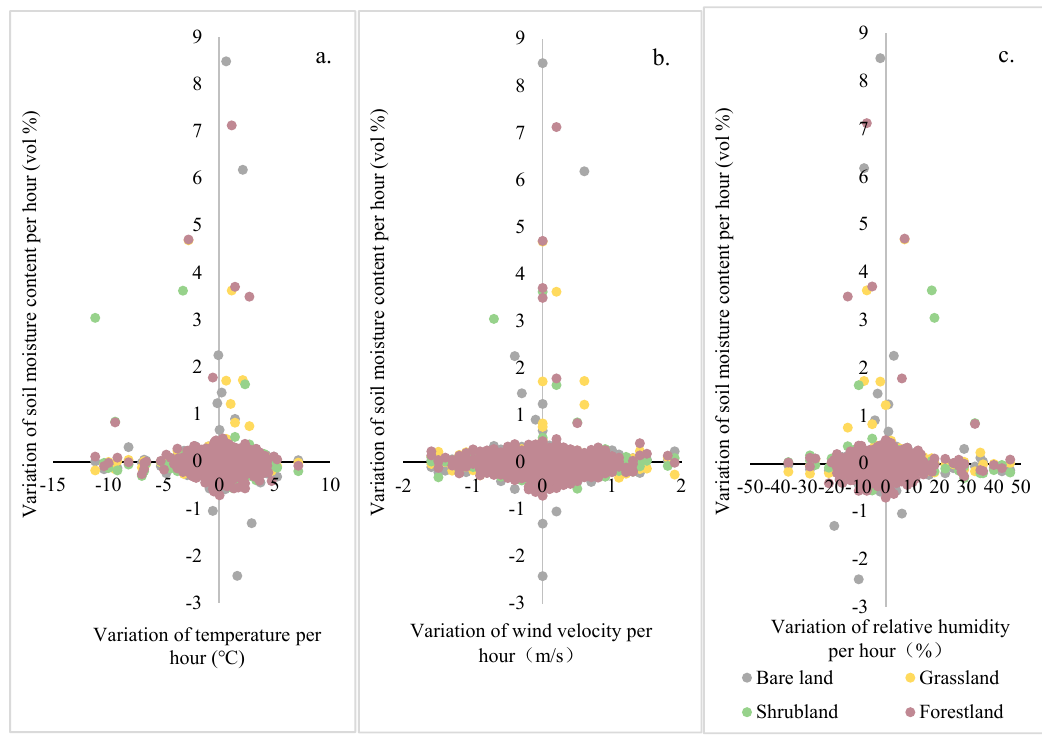
Figure 9. Volumetric soil moisture content variation per hour, with variation of temperature ( a ), wind velocity ( b ), and relative humidity ( c ) per hour during a period without rainfall. Table 12. Results of the Spearman correlation coefficient and significance level between volumetric soil moisture content variations, per hour, and variation of temperature, wind velocity, and relative humidity per hour in a period without rainfall.